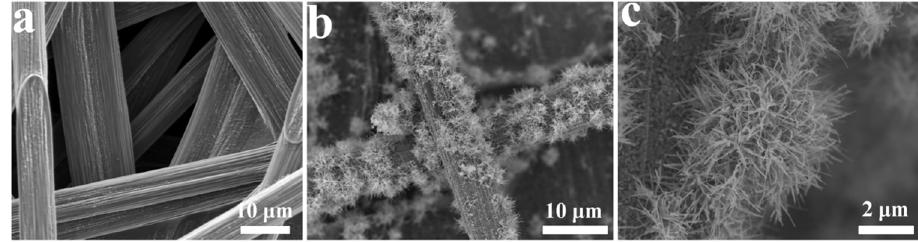
Figure 2. Morphologies of NiCo 2 S 4 -NiS 2 /CFP. ( a ) SEM of CFP, ( b , c ) NiCo 2 S 4 -NiS 2 /CFP.